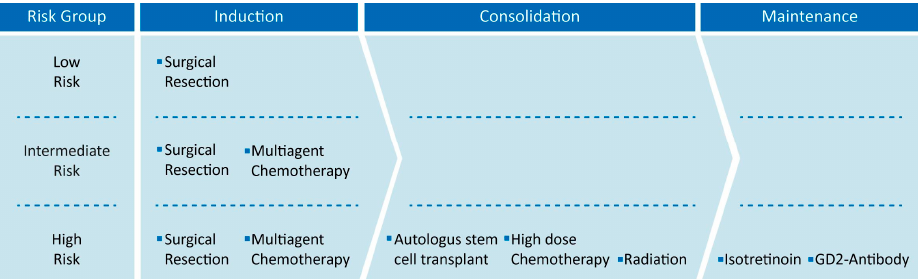
Figure 1. Neuroblastoma therapies are reported in relationship to risk group. Each treatment is collected in its own neuroblastoma therapy phase from induction to maintenance. Low- and intermediate-risk patients only receive the induction phase, while high-risk patients receive all treatments.